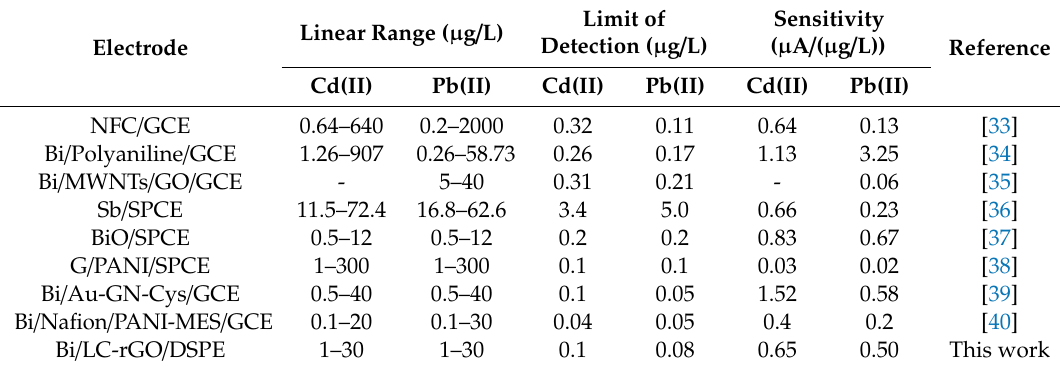
Table 1. The performances of different electrodes for Cd(II) and Pb(II) detection.